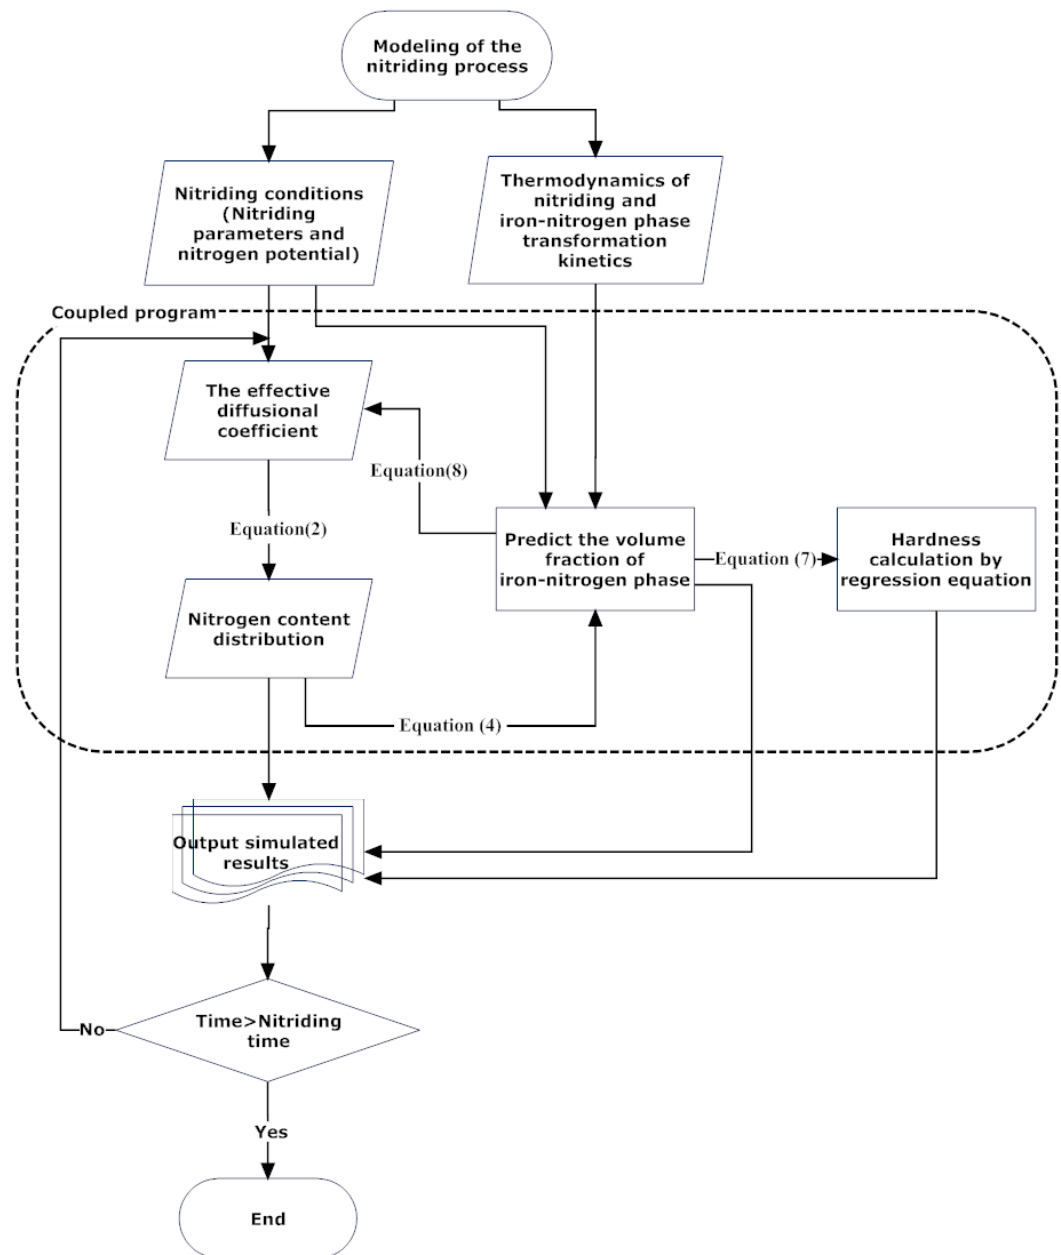
Fig. 2 The flowchart of the diffusion/transformation coupled